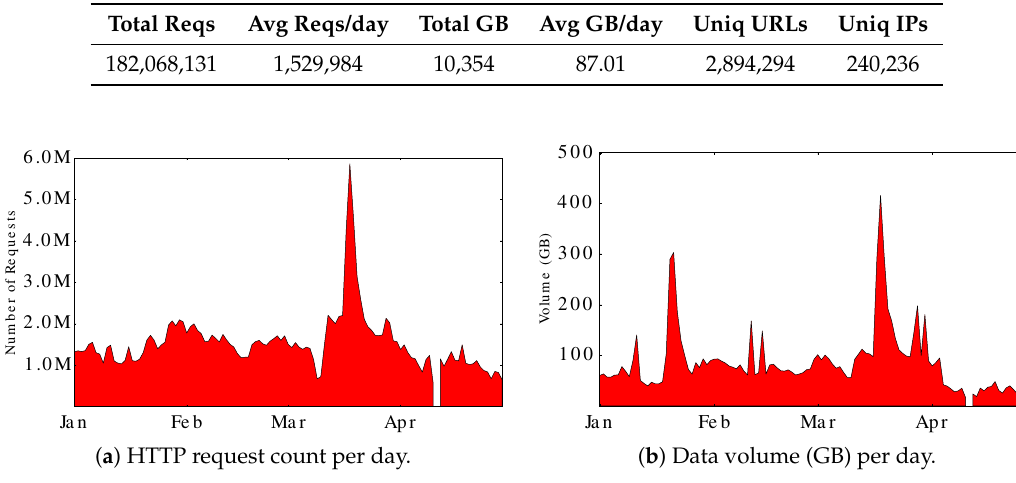
Figure 3. HTTP requests and data volume per day.